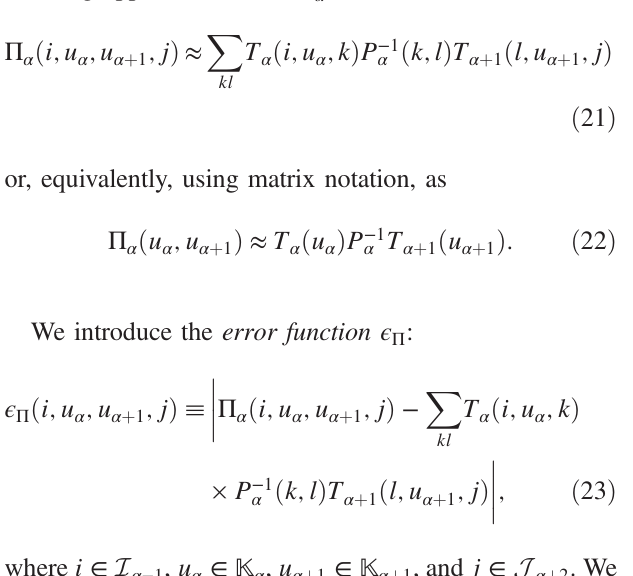
Fig. 4. Each green line corresponds to a set of multi-indices “ rows ” ) or J “ columns ” ). It is important to notice I α ( α ( that the TCI representation is defined entirely by the selected sets of rows and columns I α and J α , so that constructing an accurate representation of A amounts to optimizing the selection of I α and J α for 1 ≤ α ≤ n .